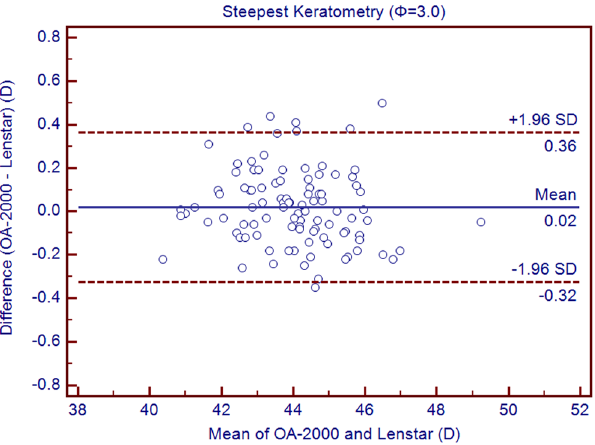
Figure 13. Bland-Altman plots show the agreement between OA-2000 swept-source optical coherence tomography and Lenstar optical low coherence reflectometry for measuring steep keratometry (Ks) at 3.0 mm. Solid lines represent the bias between both devices and dotted lines represent at the 95% confidence interval for the difference.